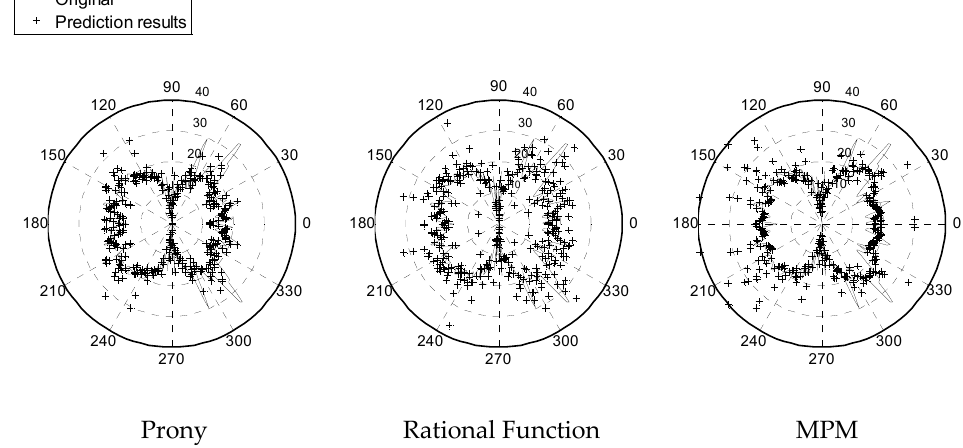
Figure 13. Transport Plane Prediction results in all directions at 7 GHz.